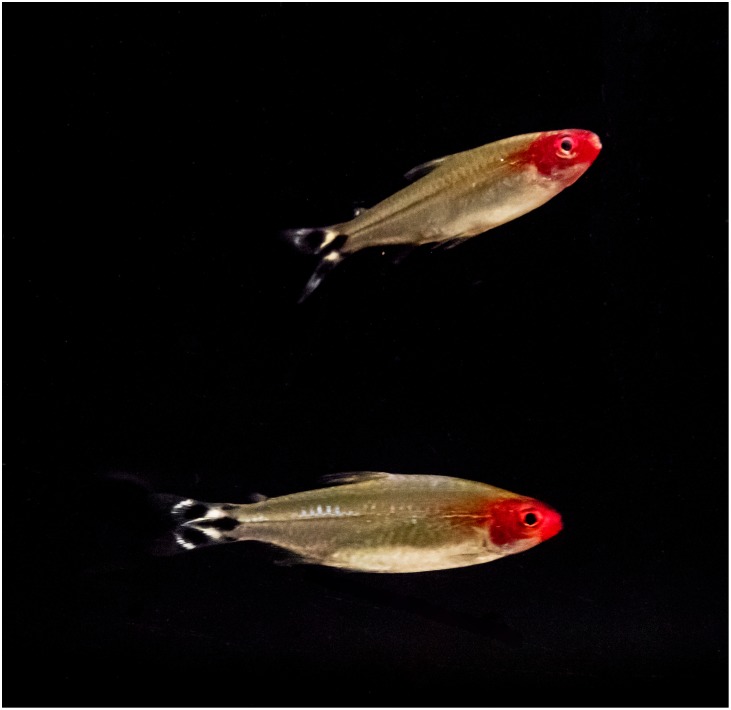
A group of two fish from the study species Hemigrammus rhodostomus.Credits to David Villa ScienceImage/CBI/CNRS, Toulouse, 2015.